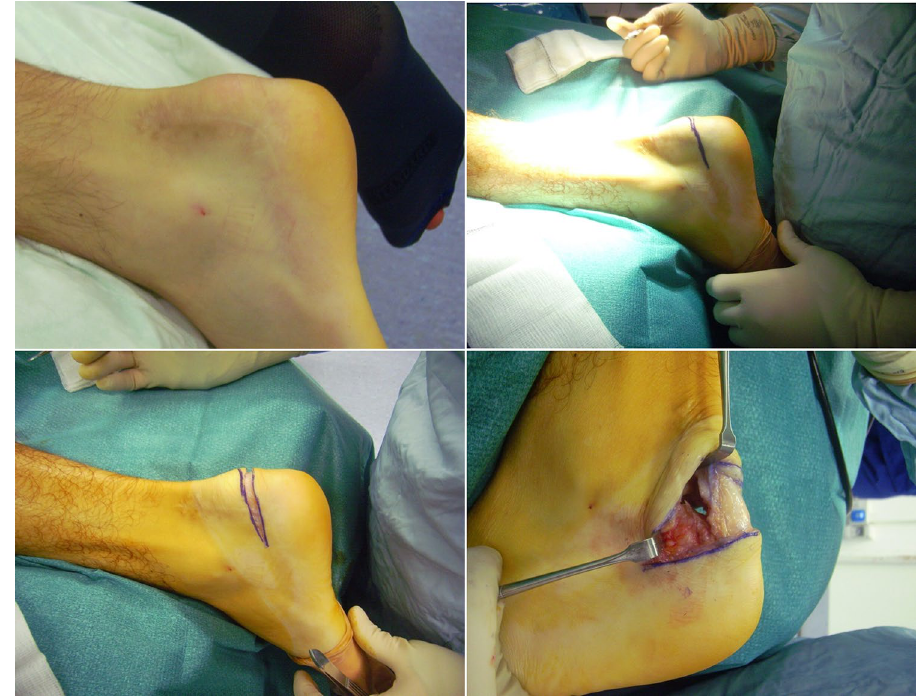
Figure 1. Failed lateral open approach revised with Cincinnati